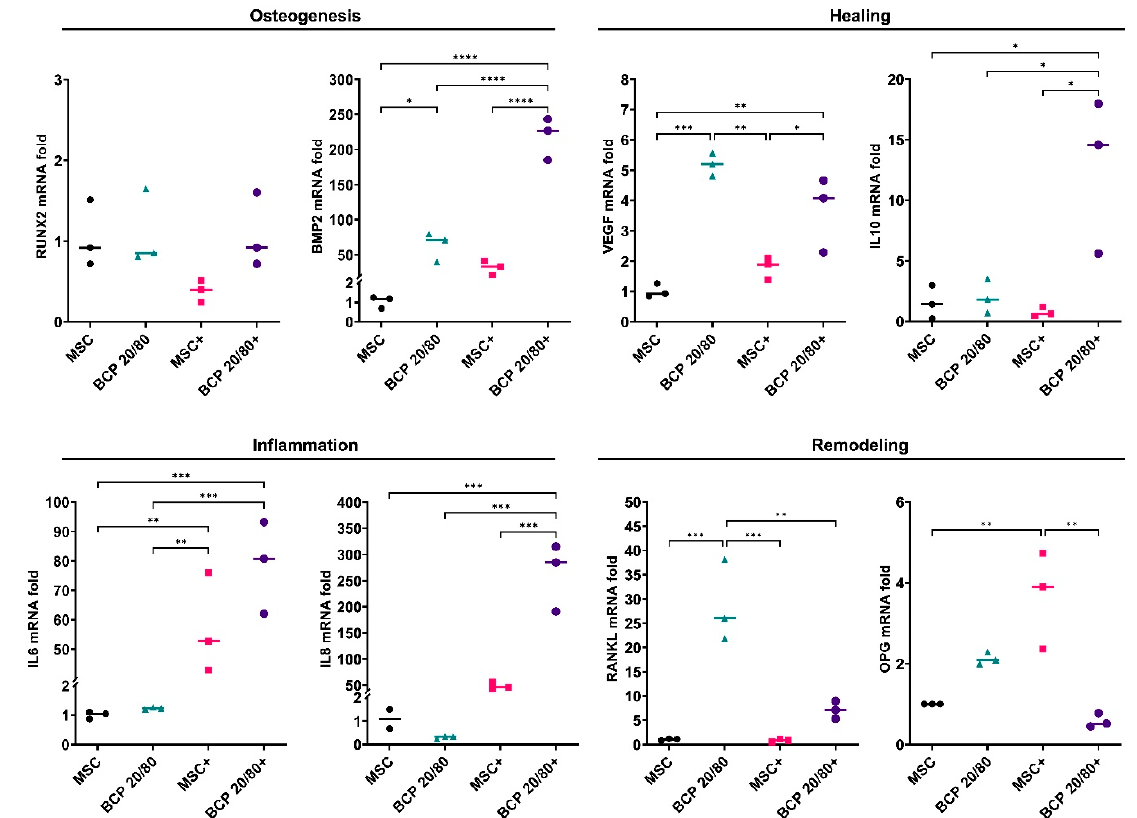
Figure 3. Relative mRNA expressions (fold changes) of osteogenesis-, healing-, inflammation- and remodeling-related genes in MSCs cultured as monolayers (control) or with BCP 20/80; + represents cytokine stimulation (n = 3). Statistical analyses are based on one-way ANOVA with Tukey’s multiple comparison tests on delta-Ct values; * p < 0.05; ** p < 0.001; *** p = 0.0001; **** p < 0.0001.